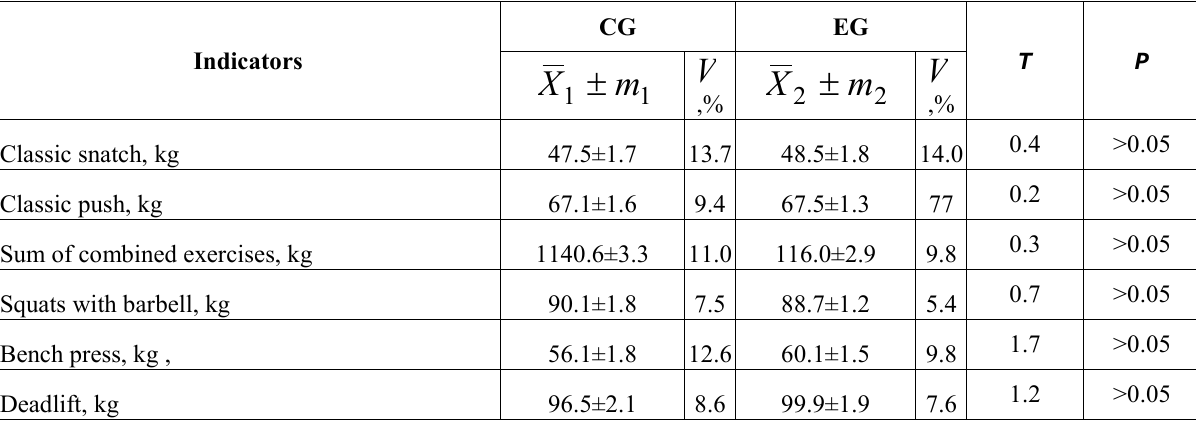
Mean indicators of competition and special preparatory exercises of junior weight lifters of control and experimental groups at the beginning of preparatory period of special preparatory